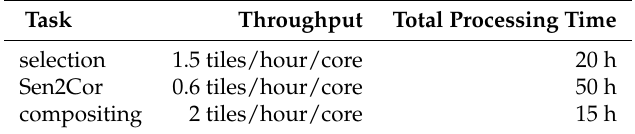
Table 2. Throughput and total processing time to create world composite (using 952